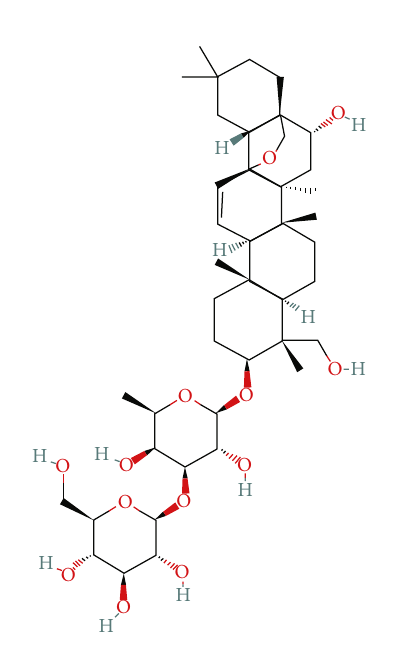
Figure 1: SSd 2D chemical